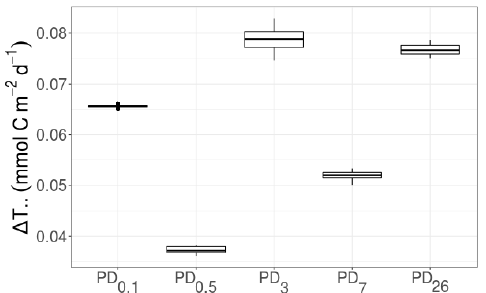
Figure 6. Development of (cid:49)T .. (mmolCm − 2 d − 1 ), i.e., the differ- ence in “total system throughput” T .. outside plough tracks com- pared to inside plough tracks, over time. PD 0 . 1 corresponds to 0.1- year post-disturbance, PD 0 . 5 is 0.5-year post-disturbance, PD 3 is 3-year post-disturbance, PD 7 is 7-year post-disturbance, and PD 26 is 26-year post-disturbance